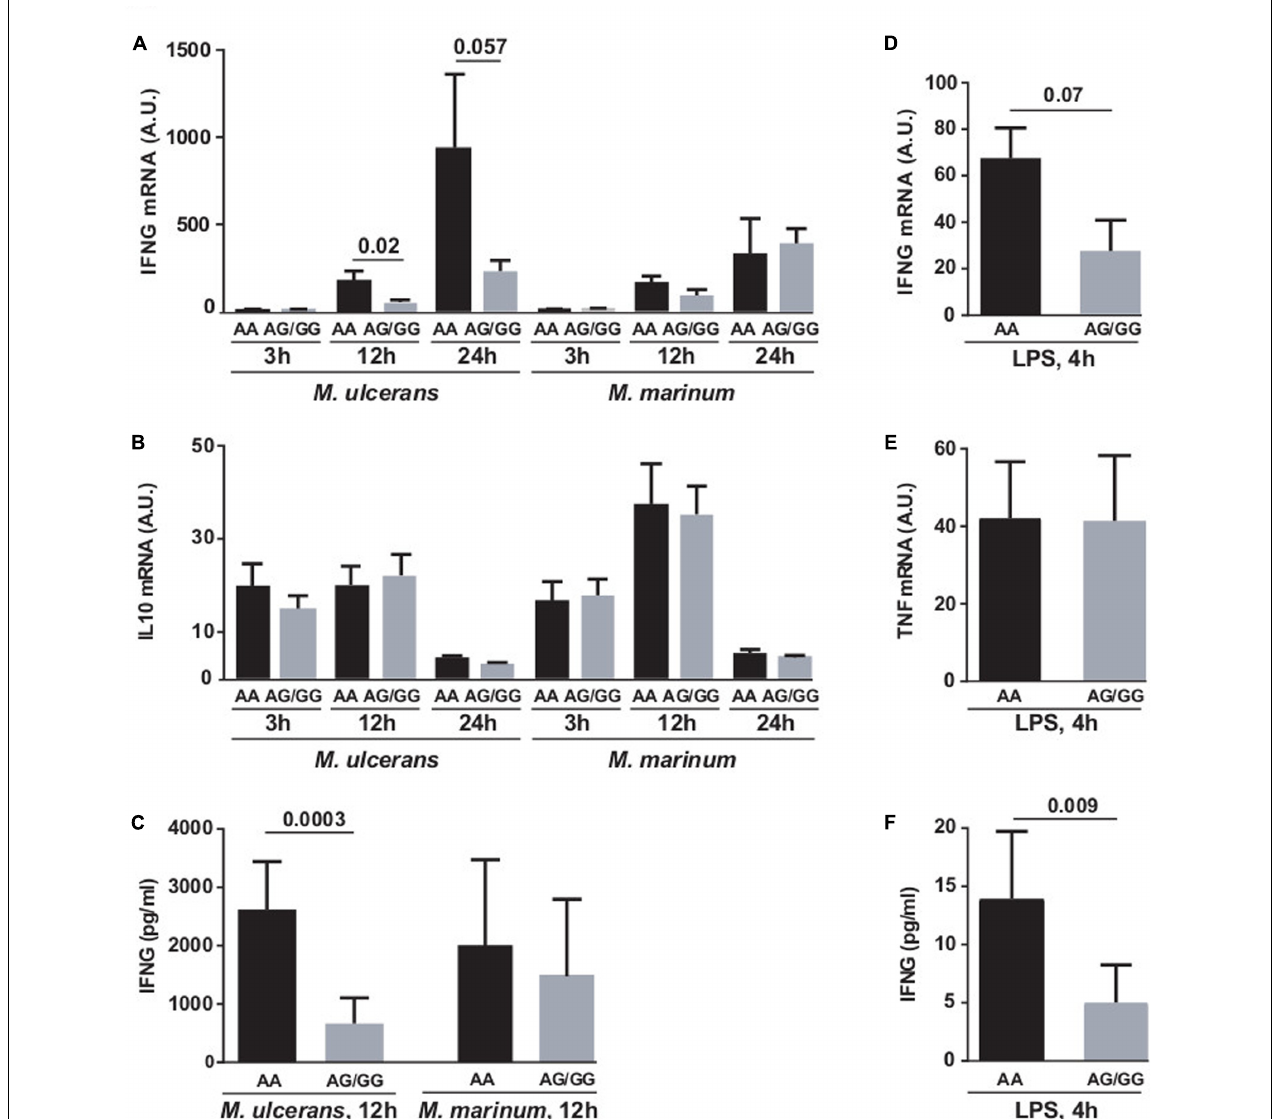
FIGURE 1 | Functional impact of IFNG rs2069705 polymorphism on IFNG expression. PBMCs from healthy Caucasian individuals were stimulated with M. ulcerans or M. marinum lysate (A–C) or LPS (D–F) for the indicated periods of time. The IFNG mRNA and protein expression was measured by RT-qPCR (A,D) and ELISA (C,F) . As controls, the IL10 or TNF mRNA expression were determined by RT-qPCR (B,E) . Data are grouped according to IFNG rs2069705 A alleles [2 copies of the A allele, black ( n = 5) and 1 copy of the A allele ( n = 6) or 2 ( n = 2) copies of the G allele (gray)]. A.U., arbitrary